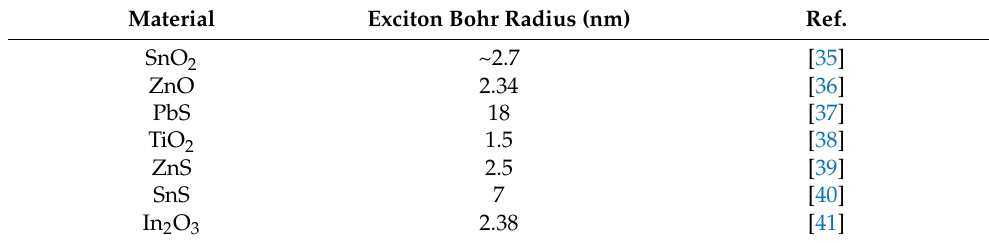
Table 1. Exciton Bohr radius of some semiconducting metal oxides used in gas sensor areas. Material